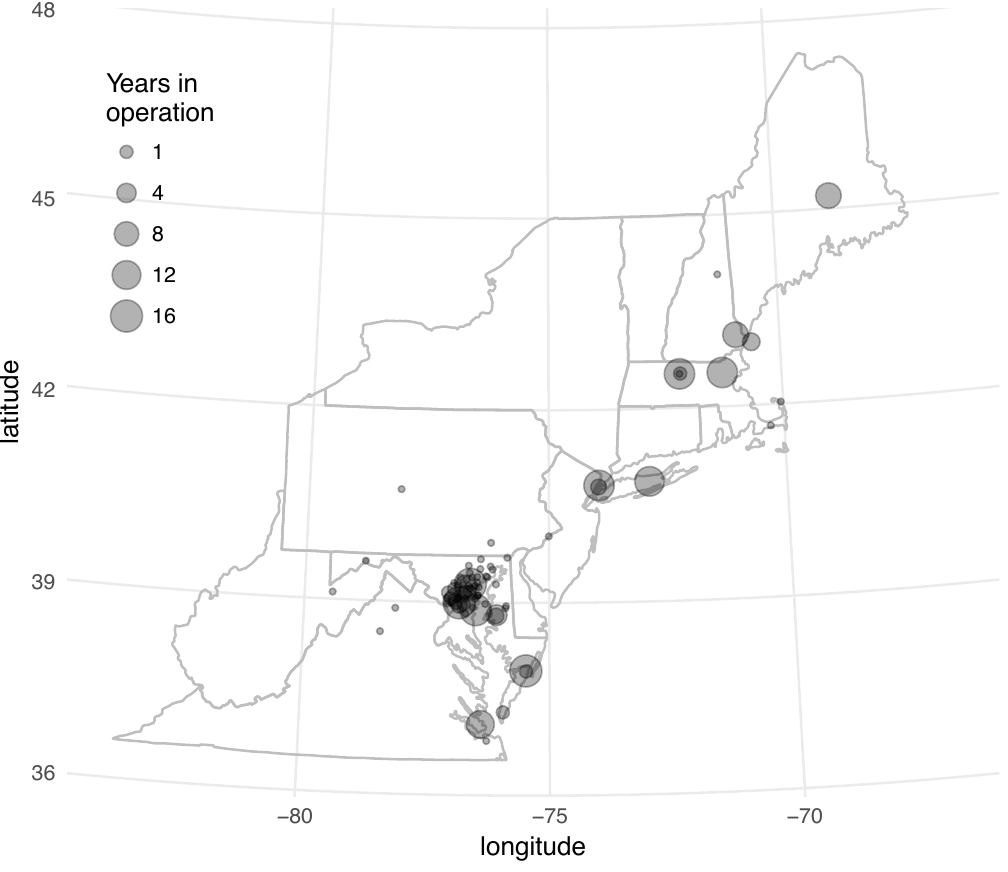
Figure 1. Study region in Northeastern and Mid-Atlantic USA with 79 unique AERONET stations showing the number of years of coverage for use in measurement error